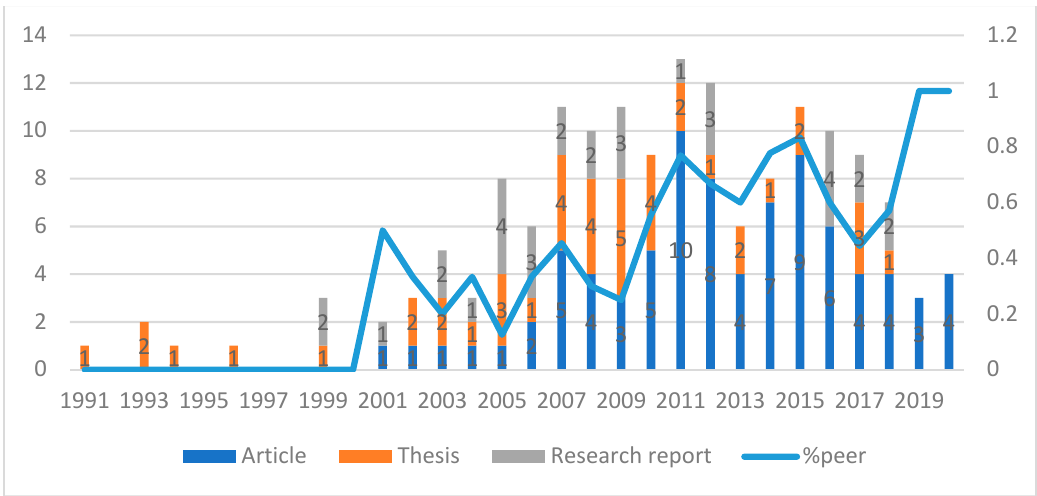
Figure 2. Overview of studies on international trade and health in Thailand.